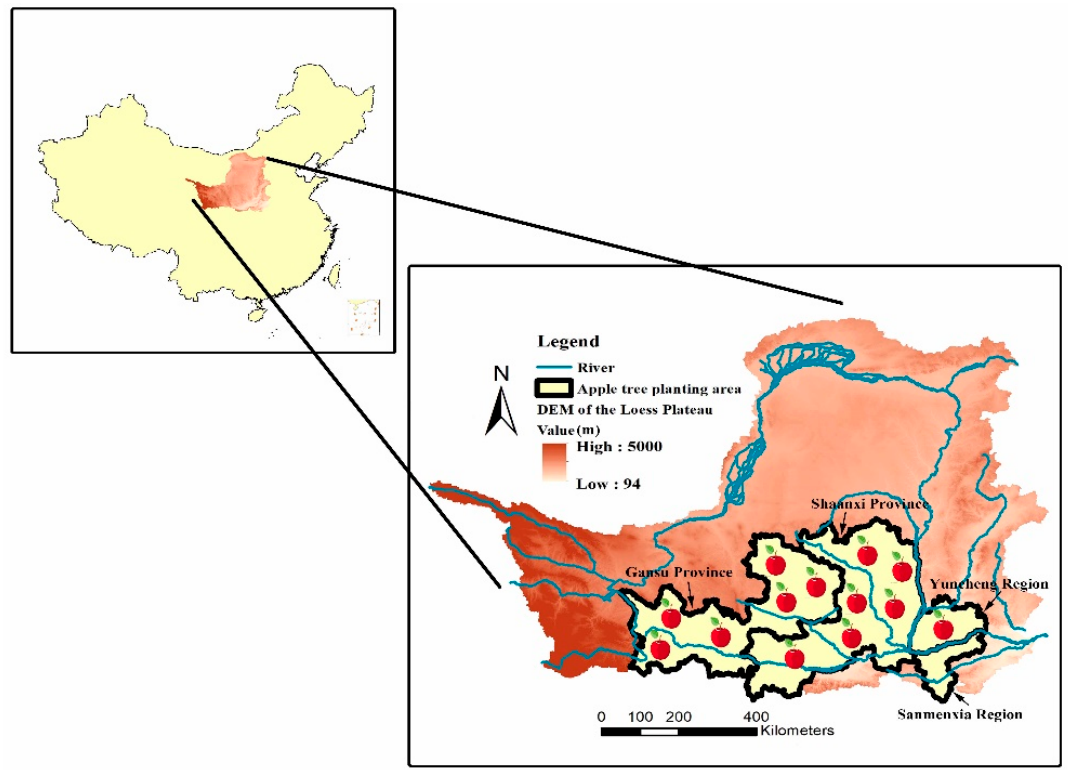
Figure 1. Location of suitable planting areas for apple trees in the Loess Plateau.